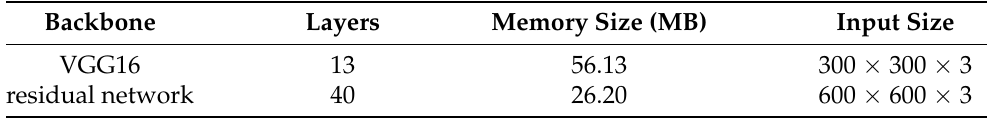
Figure 8. Effect of different improvement methods on model performance. ( a ) This shows the perfor- mance gains from residual connections and small sample augmentation; the final method adopts the two components. ( b ) This shows effectiveness of aspect ratios and saliency map augmentation based on the improved model. Table 4. Comparison of the memory occupied by VGG16 and residual